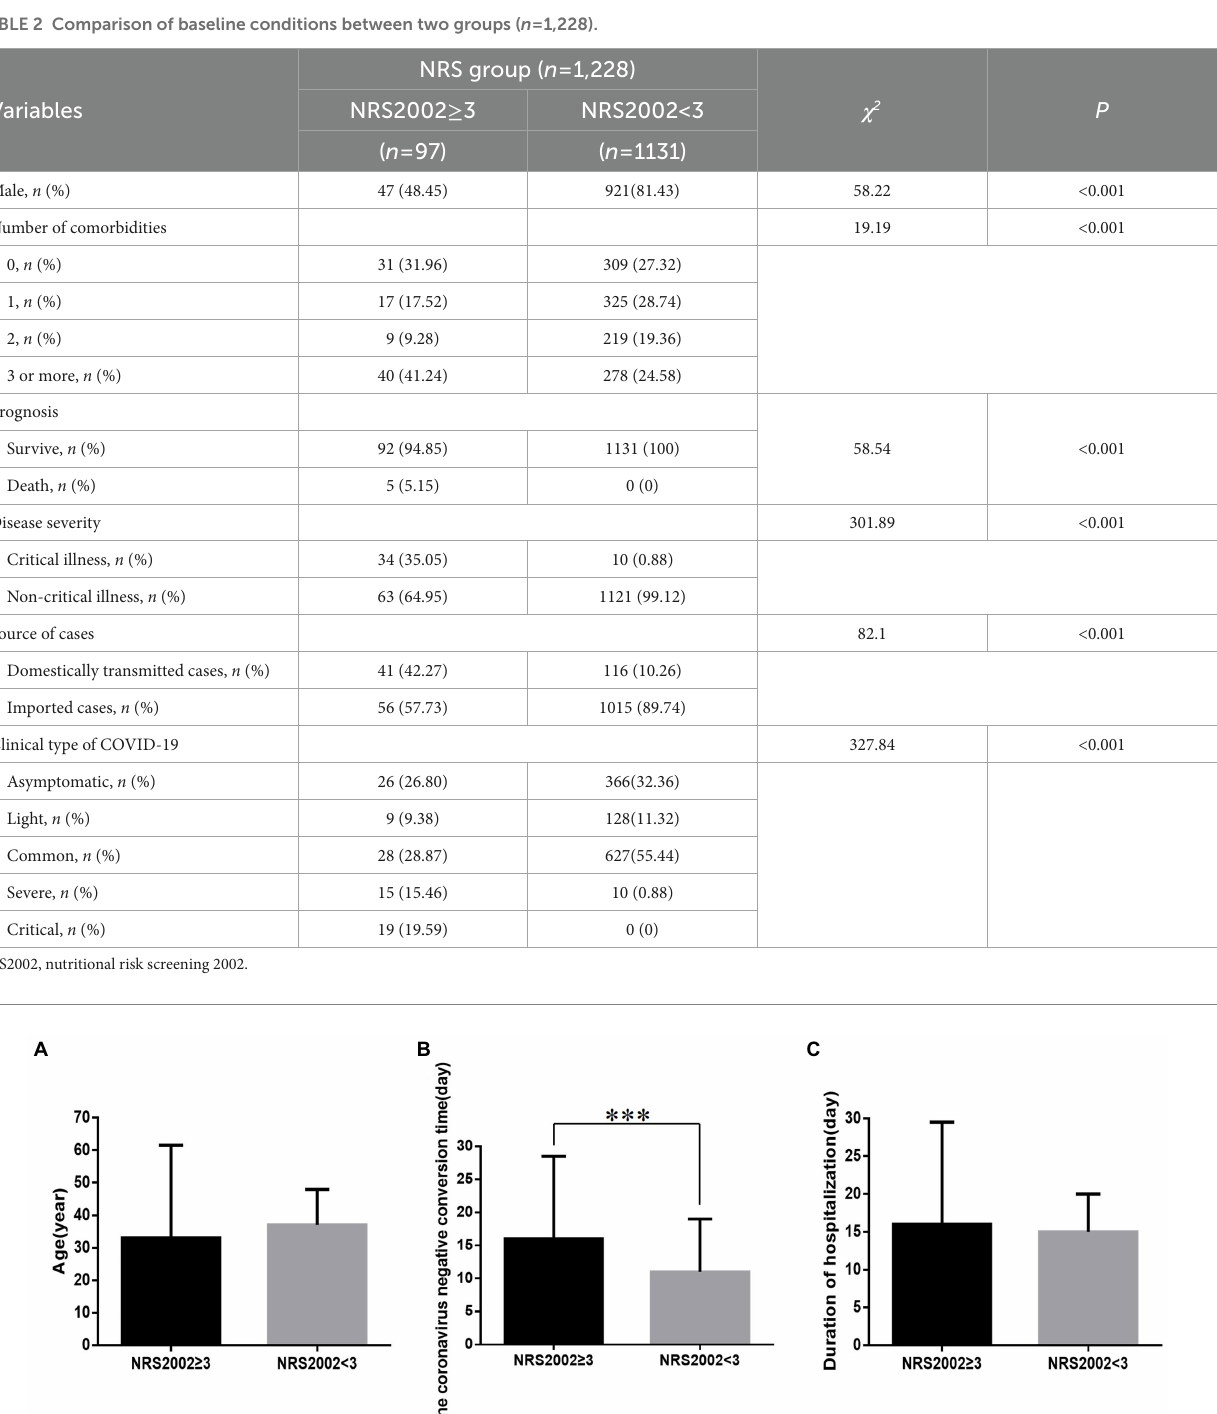
(Table 6; Figure 3) and 0.999 (Table 7; Figure 4), respectively. The thresholds were 0.5 and 5.5, respectively. The sensitivities were all 100.00%. The specificities were 89.30 and 99.60%, respectively (Tables 6, 7).